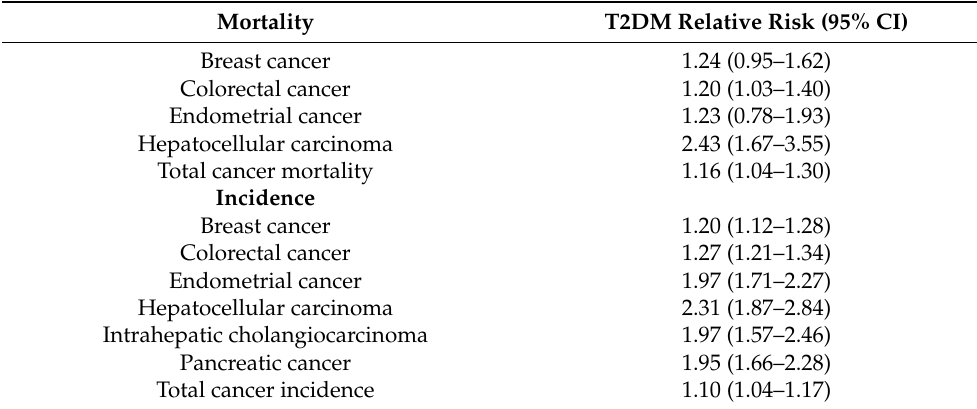
Table 3. Effect of T2DM on cancer mortality and